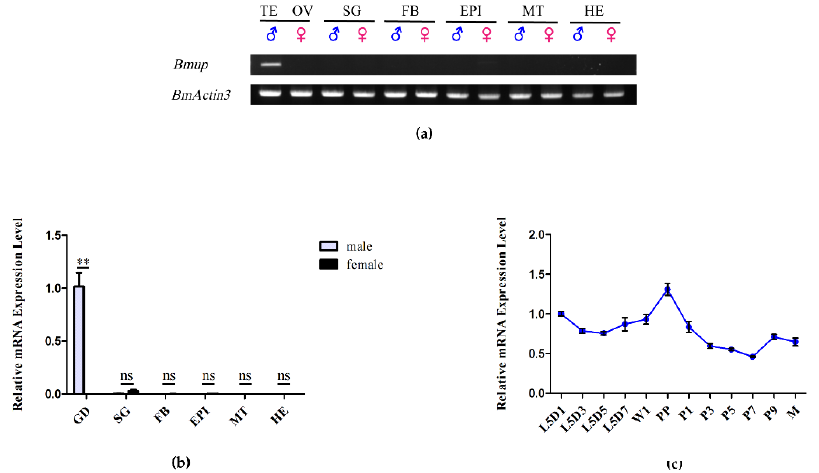
Figure 1. Expression pattern of the BmUP gene. ( a ) Semi-quantitative analysis of BmUP gene expression in each tissue of fifth-instar, 3-day-old silkworms. BmActin3 is an internal reference gene. TE, testis; OV, ovary; SG, silk gland; FB, fat body; EPI, epidermis; MT, malpighian tubule; HE, head. ( b ) Q-RT-PCR analysis of the transcript abundance of BmUP in larvae at the third day of the fifth instar. GD, gonad (** p < 0.01, ns indicates no significance). ( c ) The expression pattern of the BmUP gene in the testis from the first day of the fifth instar to the moth stage. L5D1, the first day of the fifth instar; L5D3, the third day of the fifth instar; L5D5, the fifth day of the 5th instar; L5D7, the seventh day of the 5th instar; W1, wandering; PP, pre-pupa stage; P1, the first day of the pupa stage; P3, the third day of the pupa stage; P5, the fifth day of the pupa stage; P7, the seventh day of the pupa stage; P9, the ninth day of the pupa stage; M, moth. 3.2. CRISPR/Cas9-Mediated Mutagenesis of the BmUP Gene In order to investigate whether the BmUP gene might be involved in the development of the silkworm testis, we used the CRISPR/Cas9 system to knock out the BmUP gene. We designed two sgRNAs to target the first and second exons of the BmUP gene, cloned them into the Puc57 vector and then synthesized mature gRNA through in vitro transcription (Figure 2a). Before editing, we performed an in vitro assay to assess the editing efficiency of the synthesized gRNAs. We cloned a fragment containing two gRNAs from the silk- worm genome. We then mixed gRNA, Cas9 protein and genome fragments in a restriction enzyme digestion. The experimental group yielded smaller fragments than the target ge- nome (Figure 2b). We then mixed the effective gRNA with Cas9 protein and injected them into silkworm eggs within 2 h of egg laying. Subsequently, we raised the successfully hatched eggs to the moth stage. We observed the internal and external genitalia of male moths and found that, the external genitalia of the experimental moths, compared with the wild-type moths, proliferated with rod-shaped or clasper-like tissues, and the original left-right symmetrical claspers were shifted down on one side and, consequently, could not hook the female moths during mating and allow for successful mating (Figure 2d). Moreover, we dissected internal genitalia and found that the left and right testes in the same silkworm had different sizes. To determine whether the abnormalities in the exter- nal genitalia were caused by knockout of the BmUP gene, we performed genomic testing on the abnormal individuals and cloned the fragment containing both gRNAs for se- quencing (Figure 2c). We detected various editing forms at the position of the gRNA (Fig- ure 2e).